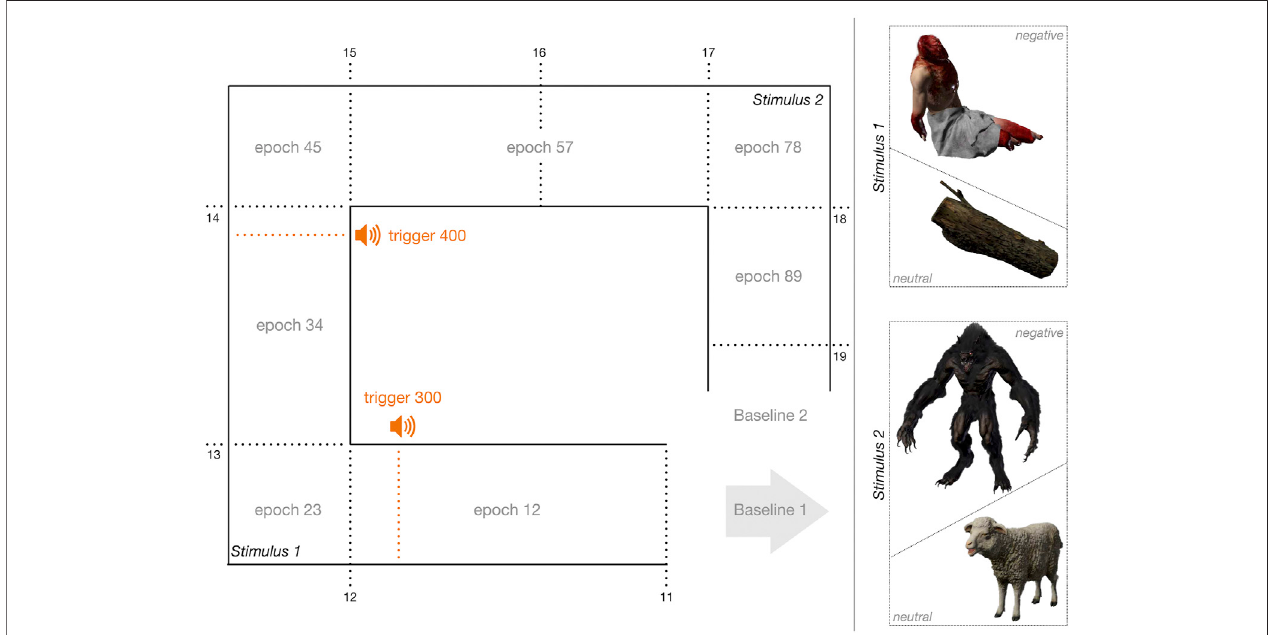
FIGURE 2 | Schematic layout of the virtual cave and exploration epochs. The gray arrow indicates the initial position and the gaze direction for all participants. The positions of relevant objects (see stimuli 1 and 2) are indicated respectively. Dotted lines mark the positions and triggers sent to EEG. The sections of the route through the cave are marked as epochs. For example, epoch 12 denotes the section between triggers 11 and 12. Prominent event within the cave are marked respectively. Epoch 12: Walking towards the corpse/tree trunk and sound of crying/wind howling; epoch 34: Walking away from the corpse/tree trunk and sound of roaring/ bleating; epoch 57: Walking towards the werewolf/sheep; Trigger 300: Crying/wind sounds; Trigger 400: Roaring/bleating.